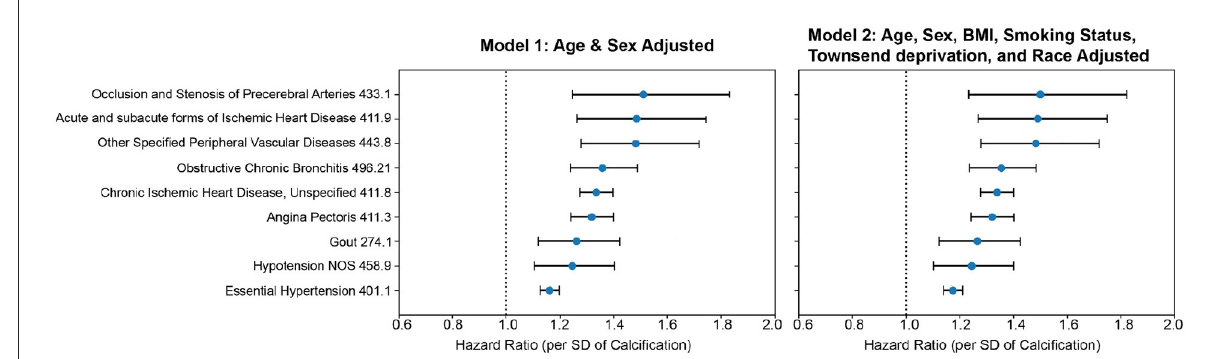
FIGURE5 CoxPH association of AAC with prognosis outcomes. Forrest plot shows hazard ratios for statistically significant disease associations after multiple hypothesis testing. The blue dots represent the mean hazard ratio, the error bars represent 95% confidence intervals. We tested 174 diseases with more than 25 events post-baseline for association with AAC using the Cox PH model. Only 10 associations that passed multiple hypothesis tests in model 1 were reported here. The number of events post-baseline for all tested diseases can be found in Table S14. (Methods Section “Prognostic analyses of aortic calcification”).